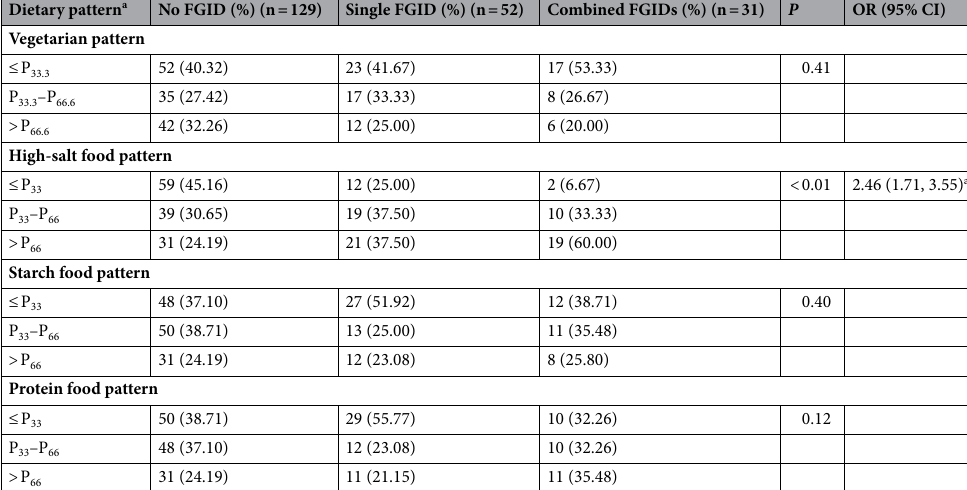
Table 3. Food patterns for different FGID groups.